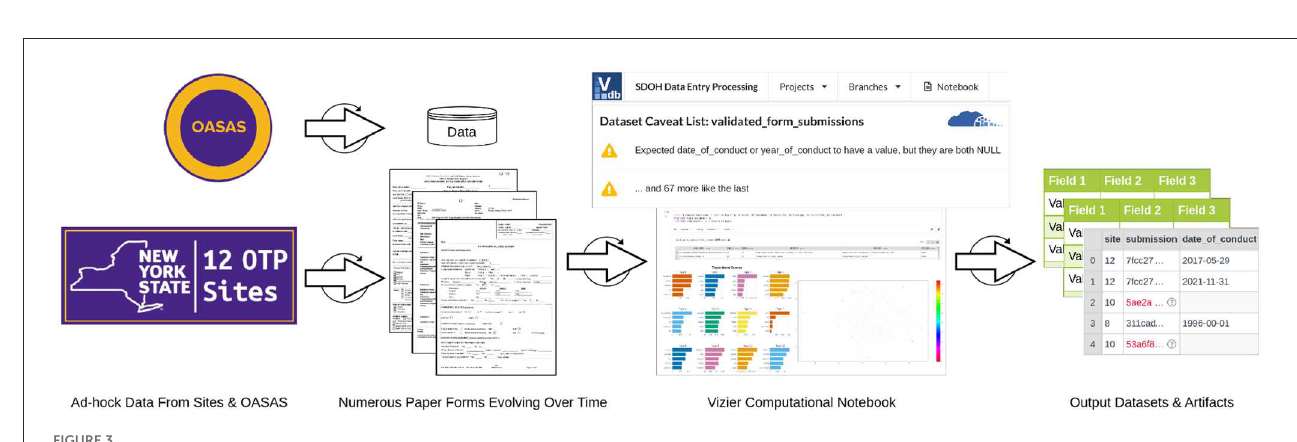
FIGURE3 Iterative flow of data during ad-hoc collection and